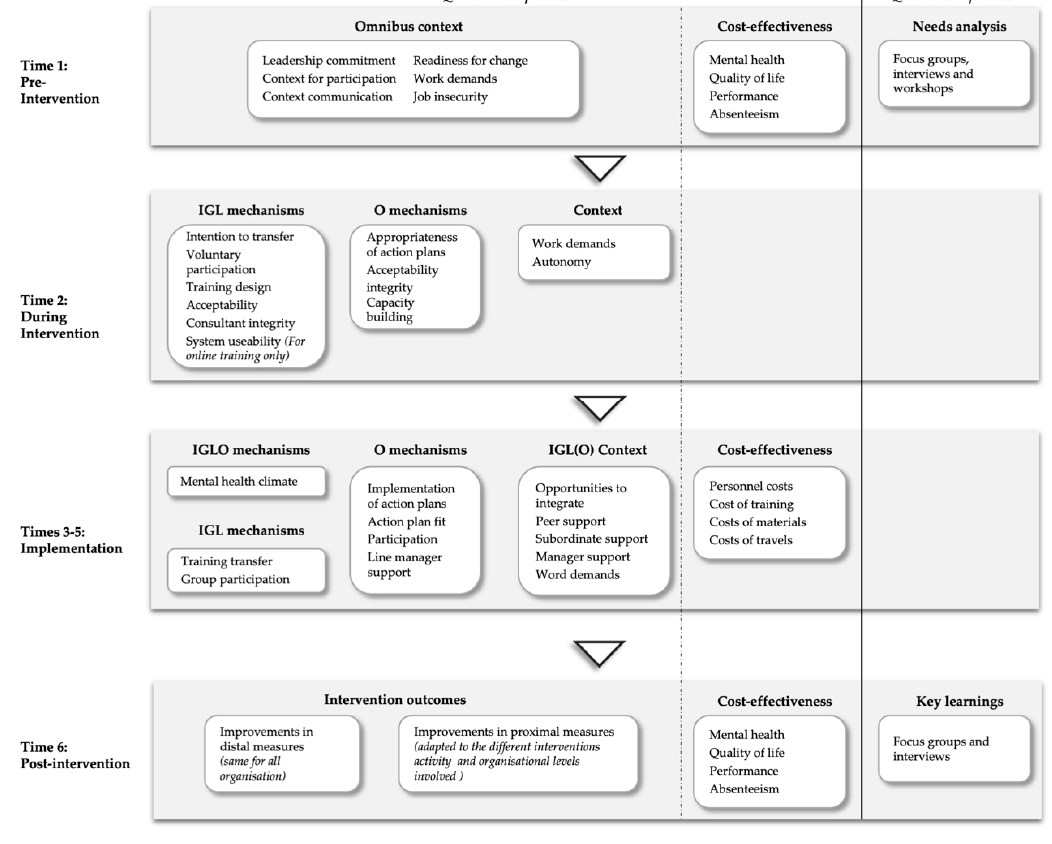
Figure 3. The H-WORK HET.